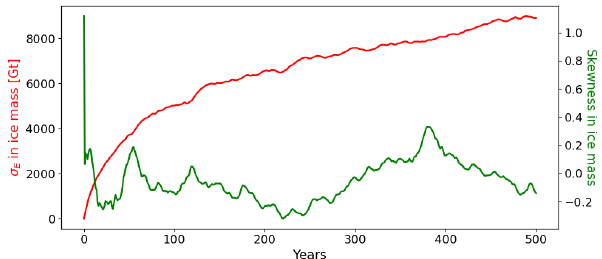
Figure 9. Evolution throughout the transient experiment of (red) the standard deviation and (green) the skewness in total ice mass for the GrIS